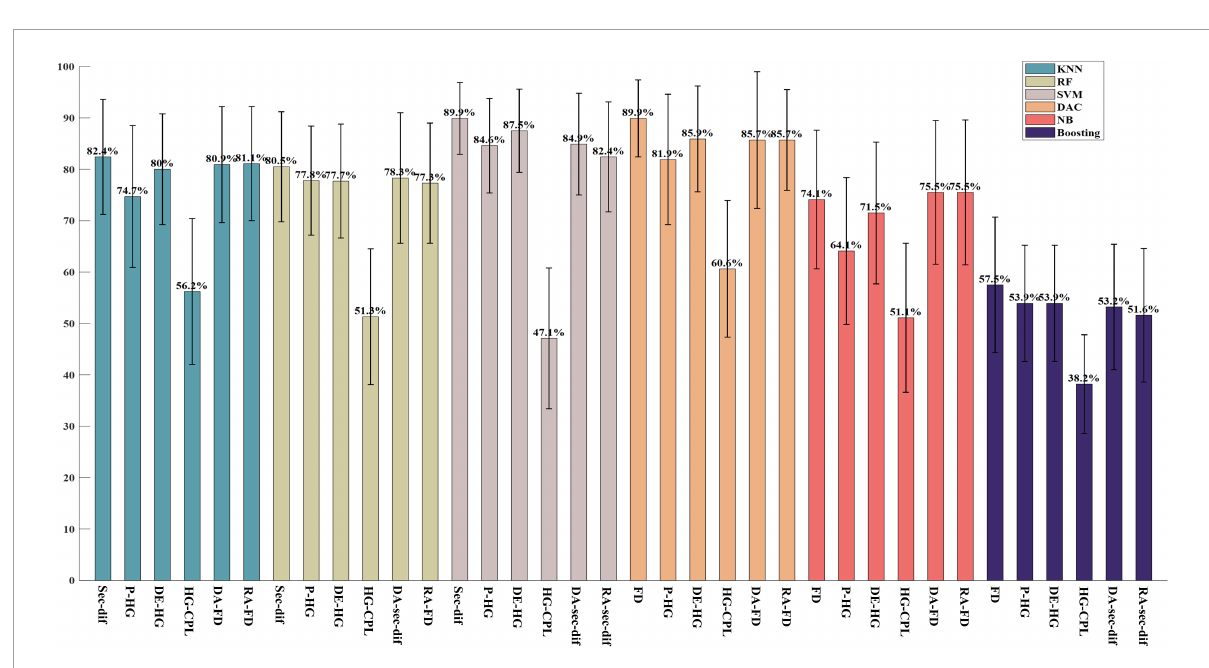
FIGURE2 The highest five-class classification accuracy in each feature domain on the ESD. The block which including six bars of same color is the results of same classifier and from left to right, it is the classification results by classifiers KNN, RF, SVM, DAC, NB, and Boosting, respectively.